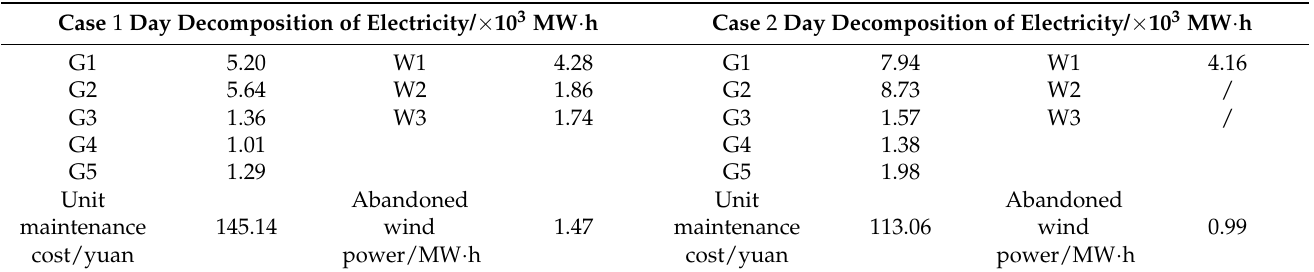
Table 4. Decomposition results of contracted electricity for bidding units.